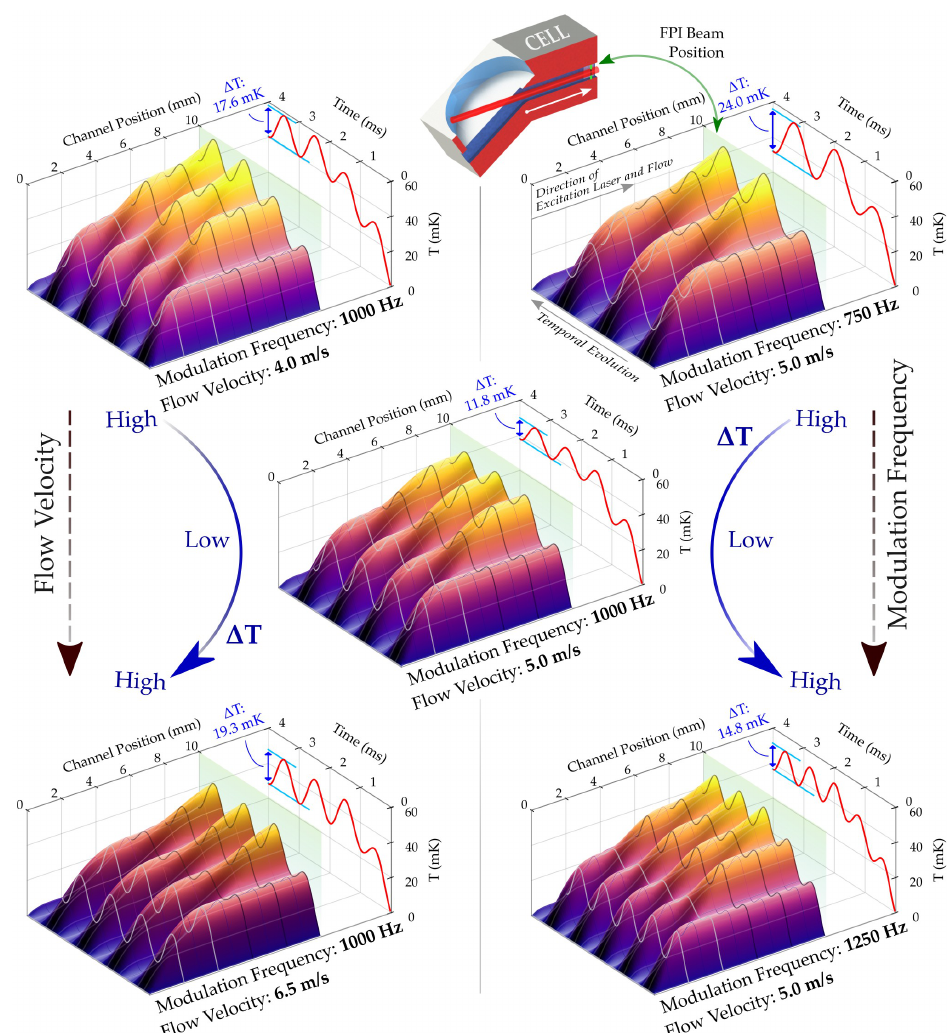
Figure 4. Temporal and positional temperature evolution at the channel centerline for different flow velocities ( left ) and modulation frequencies ( right ). The channel position axis represents the x -position inside the excitation channel. The variation in temperature ∆ T (plotted at the red line as peak-to-peak) at the position of the FPI beam (translucent green plane) initially decreases towards both a higher flow velocity and modulation frequencies (top to center plot) before increasing again (center to lower plots). The center plot configuration shows an unfavorable relationship between flow velocity and modulation frequency at 1000 Hz and 5.0 m/s by yielding a low ∆ T . The illustration on top shows a cross-sectional view of the excitation area of the used PT